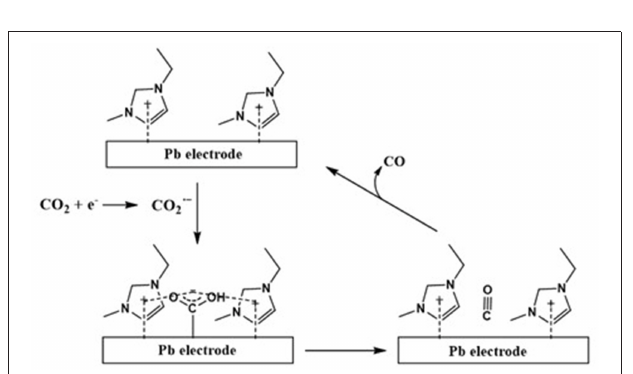
FIGURE 2 | The electrochemical reduction pathway for CO 2 to CO at Pd electrode in acetonitrile. Adopted from Sun et al. (2014).